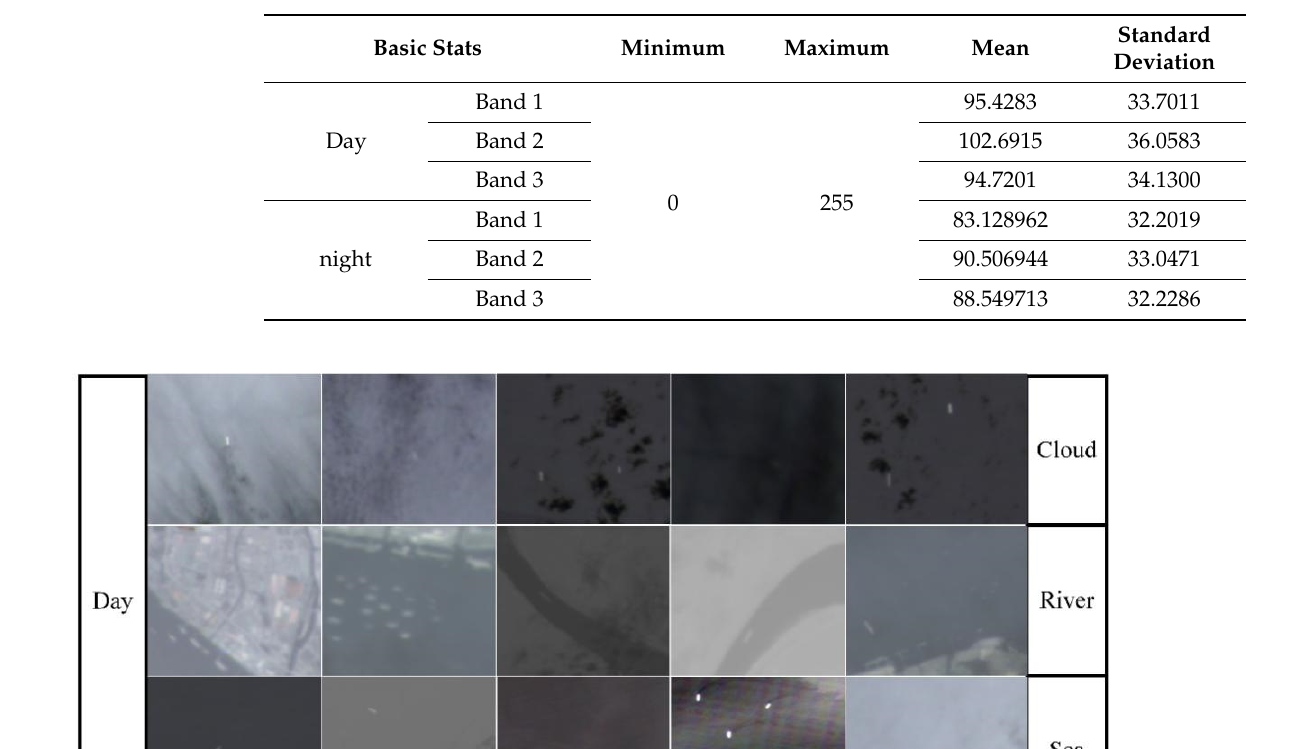
Table 3. The statistics of digital numbers in the TISD’s images.